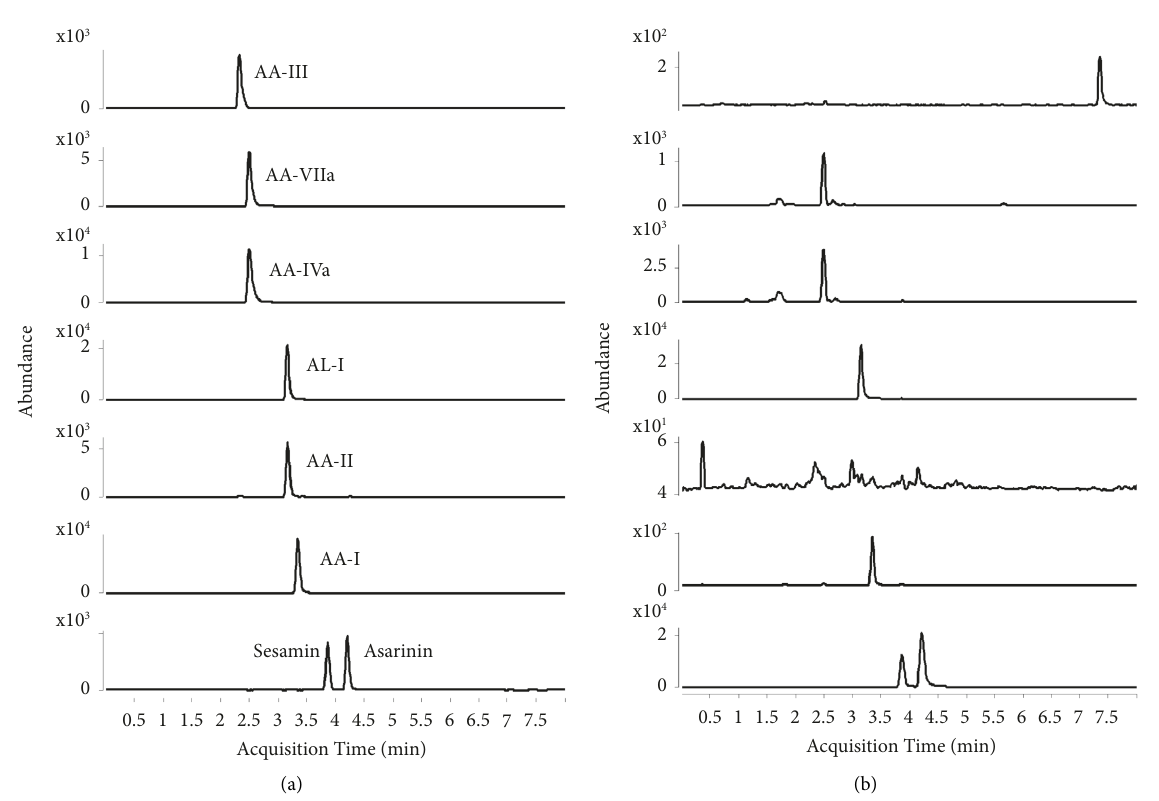
Figure 2: Liquid chromatogram of analytes in MRM mode. (a) MRM of mixed standards and (b) MRM of AR extract